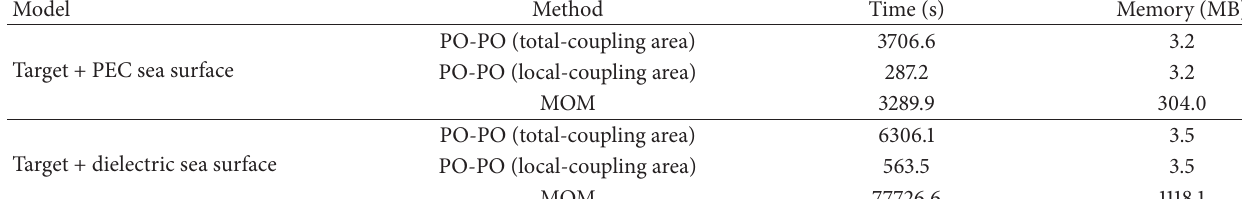
Table 1: Comparison of CPU time and memory.